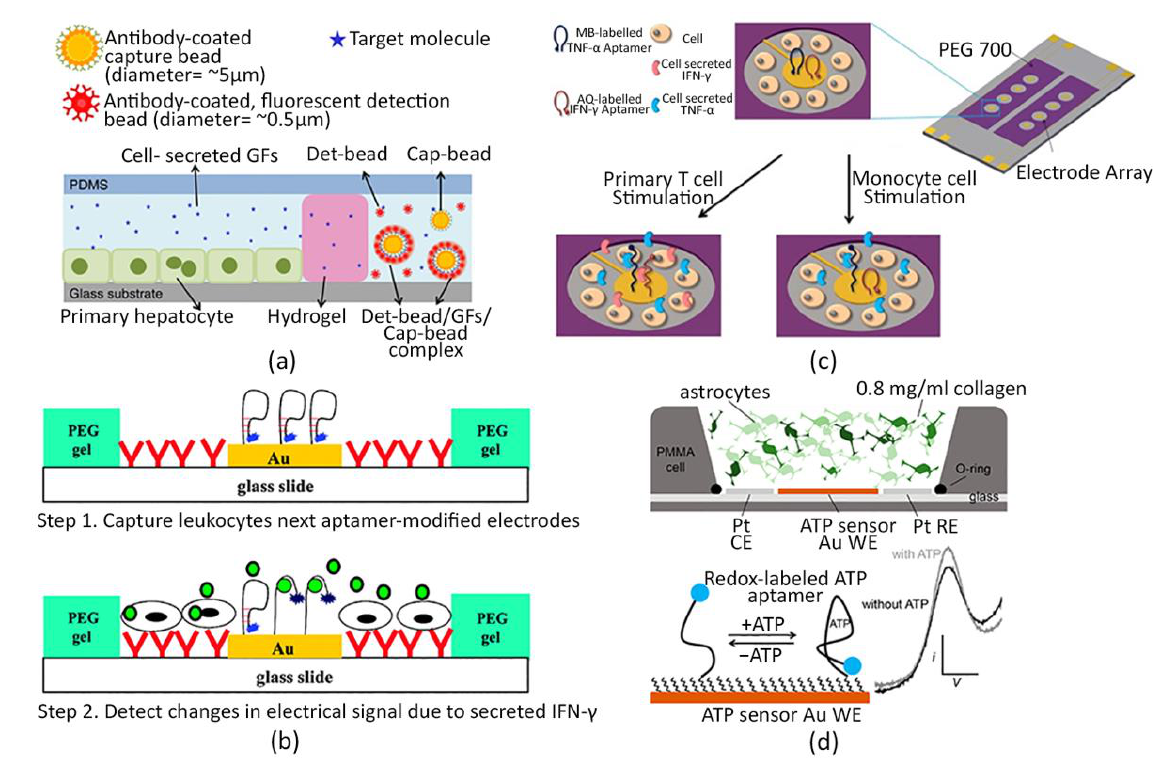
Figure 5. Cell-secreted molecules detection. ( a ) Illustration of the microfluidic chip composed of two chambers for human primary hepatocytes cultivation and cell-produced growth factors (GFs) quantification, respectively. The chambers are separated by a 3D PEG hydrogel barrier, which allows cell-released molecules to diffuse towards the sensing region, where polystyrene Ab-modified microbeads are injected to monitor local GFs concentrations [237]. ( b ) Scheme of the aptasensor design. Aptamer-modified Au electrodes are fabricated on glass slides provided with T-cell-specific Abs. PEG hydrogels surrounding the electrodes define cell attachment sites in the proximity of the sensing domains (top); T cells are captured on Ab-functionalized glass regions next to the aptasensors which detect leukocytes-released IFN γ (bottom). ( c ) Arrays of Au microelectrodes modified with a mixture of aptamers for IFN γ or TNF α binding labelled with thraquinone (AQ) and methylene blue (MB), respectively. T-cells or monocytes are bound next to aptasensors, changing their conformation after cytokines binding. ( d ) Cross-sectional image of the sensor/3D cell culture set-up. A commercial PMMA holder assembled on a glass surface contains a three-electrodes system directly interfaced with a 3D collagen hydrogel for astrocytes cultivation and stimulation inducing ATP production (top); Aptamers immobilized on the sensing electrode surface switch their structure upon ATP binding, resulting in a quantitative electrical signal change (bottom). ( b ) Adapted and reprinted with permission from [258]. Copyright (2011) American Chemical Society; ( c ) Adapted and reprinted from [260], Copyright (2015), with permission from Elsevier; ( d ) Reprinted with permission from [272]. Copyright (2019) American Chemical